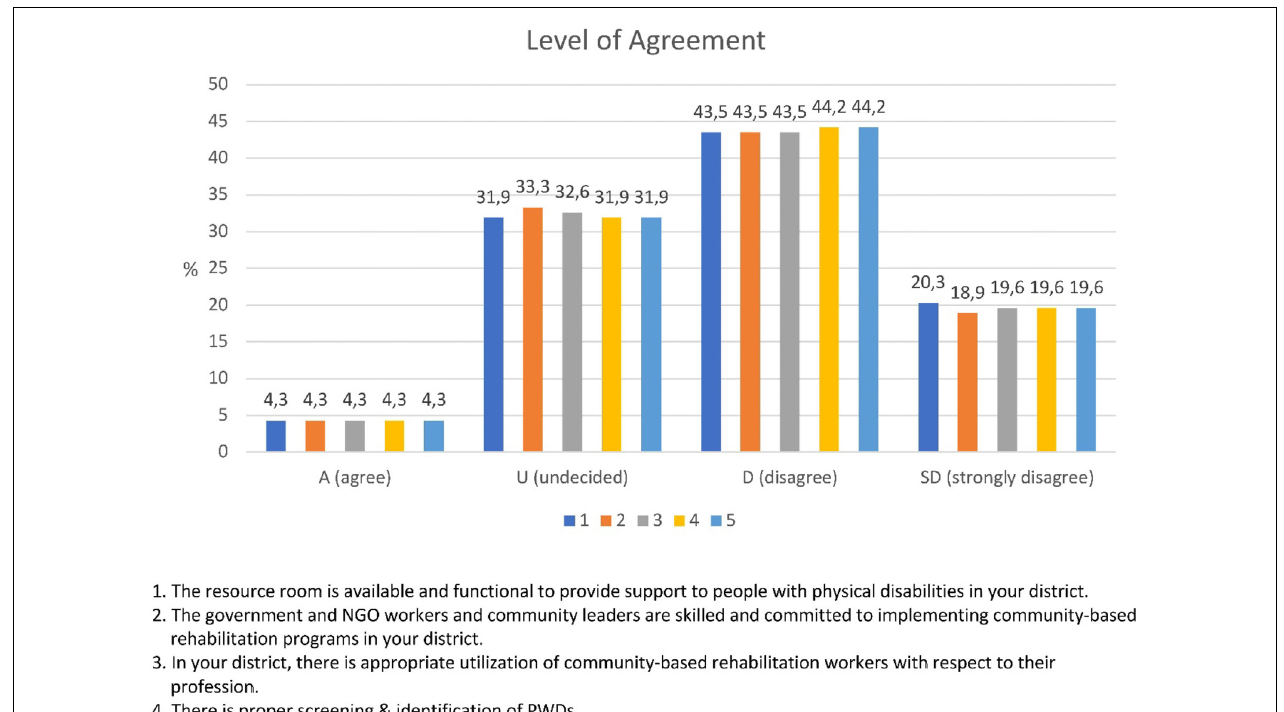
FIGURE 7 | Challenges of CBR